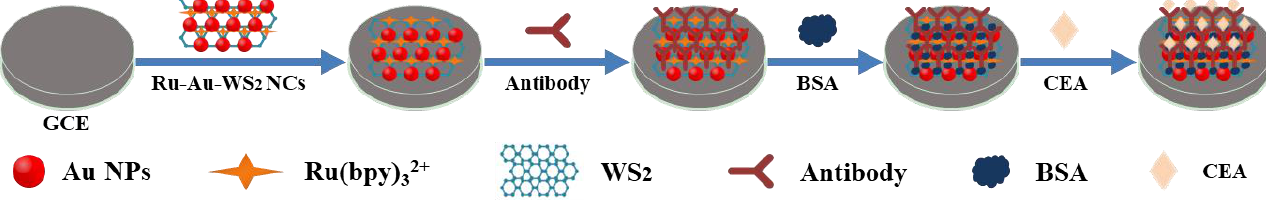
Figure 1. The schematic preparation process of immunosensor.